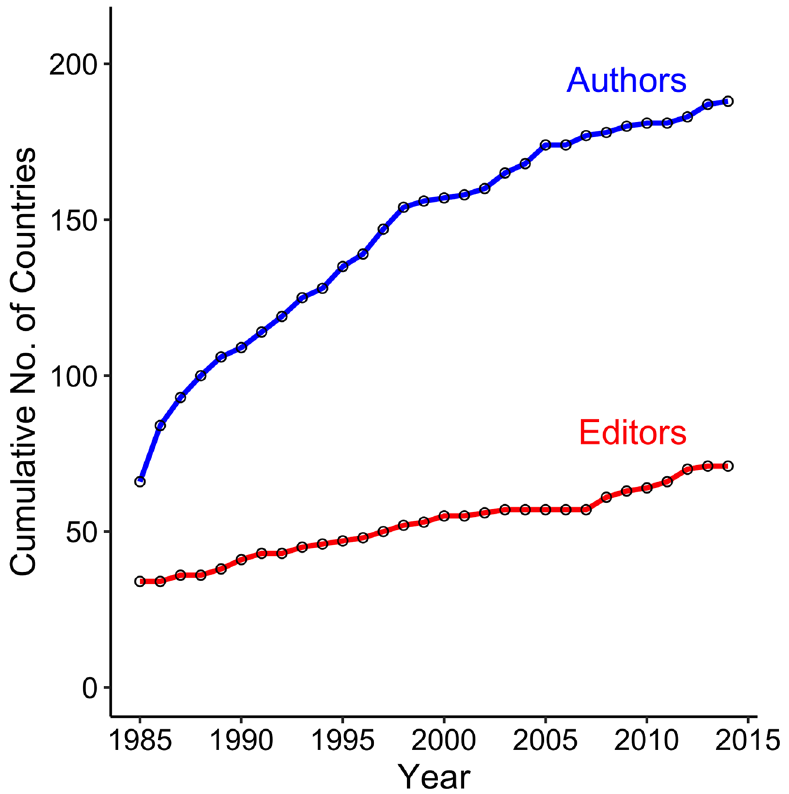
Fig 3. Cumulative geographic richness of editors and authors in environmental biology (1985–2014). Rarefactioncurves were generatedusing data on the editorialboard membershipof 24 environmental biology journals(S1 Table) and the institutionaladdresses of authors publishingin those journals( N = 113,256 publications; S1 Text). The DOIs for the datasets used in this paper (both archivedat Dryad) are https://doi. org/10.5061/dryad.6jn86.2 and